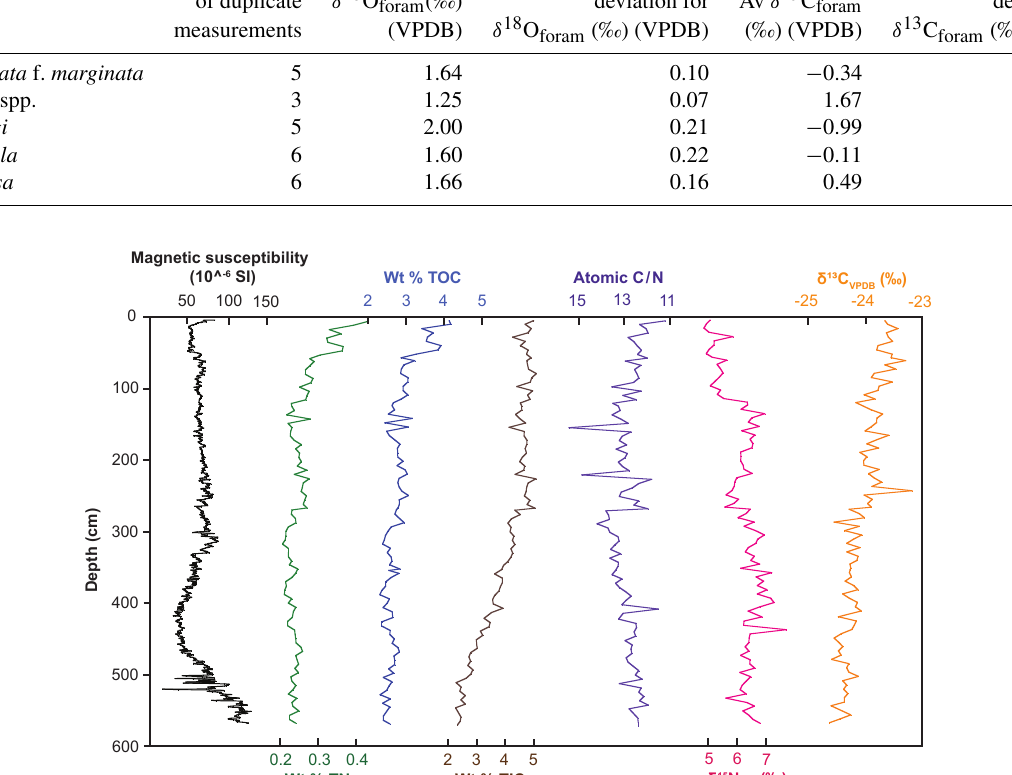
Table 3. Average benthic foraminifer oxygen and carbon isotopic compositions ( δ 18 O foram and δ 13 C foram ) from grab and box-core sediments collected from Hanfield (sites 36 and 39) and Norman Inlet (site 35) in 2014. Species Number Average Standard Standard of duplicate δ 18 O foram (‰) deviation for Av δ 13 C foram deviation for measurements (VPDB) δ 18 O foram (‰) (VPDB) (‰) (VPDB) δ 13 C foram (‰) (VPDB) 5 1.64 0.10